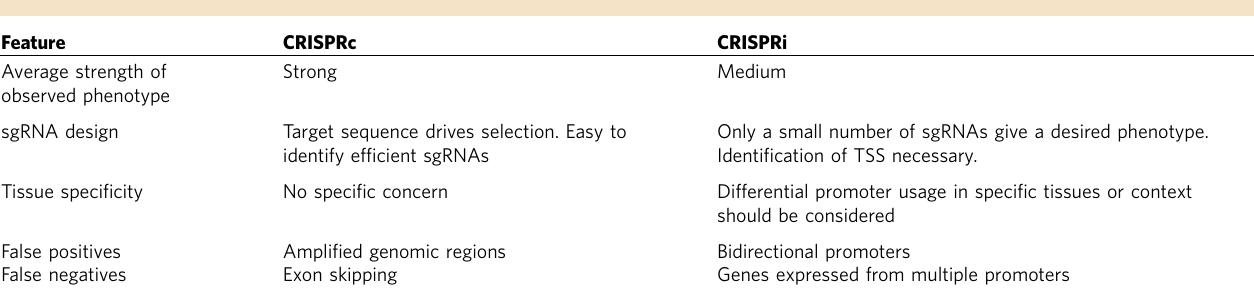
Table 1 | Pros and cons of CRISPRc and CRISPRi. Feature CRISPRc Average strength of observed